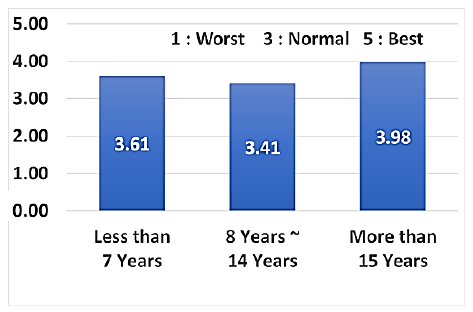
Figure A6. Users’ understanding of the term ‘MENU’ by experience of GPS plotter usage. Average (1: Worst to 5: Best).